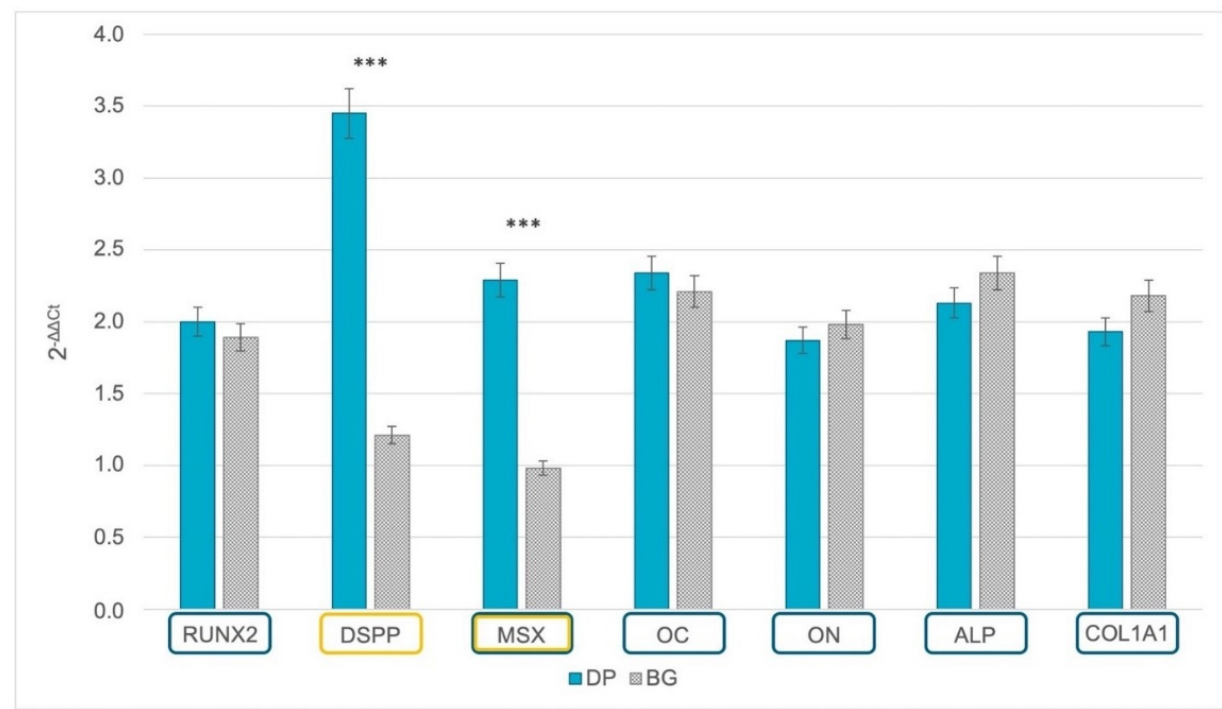
Figure 3. Real-time PCR of odontogenic and osteogenic markers highlighted in orange and blue, respectively. Gene expression levels of the selected markers are compared between the samples derived from DP (petrol blue bars) and BG granules (grey bars) after 21 days of culture. The graph shows the mean ± SD of three different experiments *** p < 0.001. Fold obtained with compared to the related value of cells cultured onto plastic supports. Time of culture was 21 days.